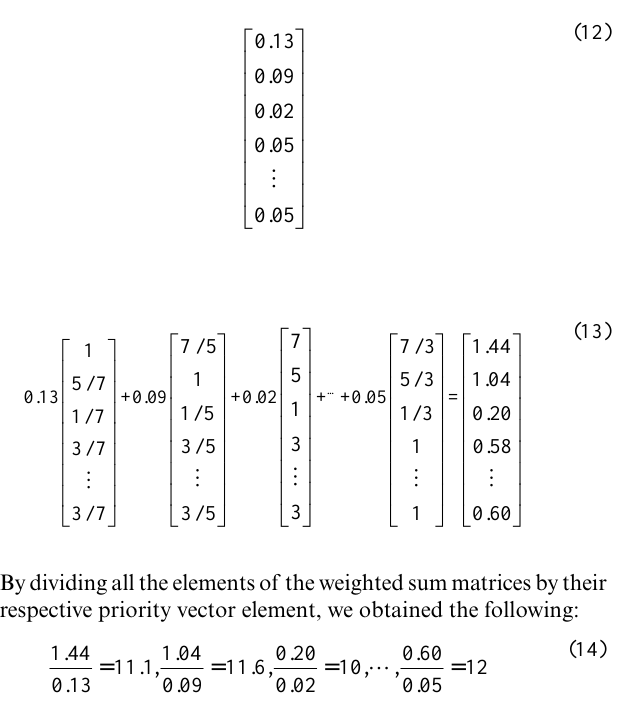
Table 4 . Pairwise comparison scale for the agent preferences. Variables A